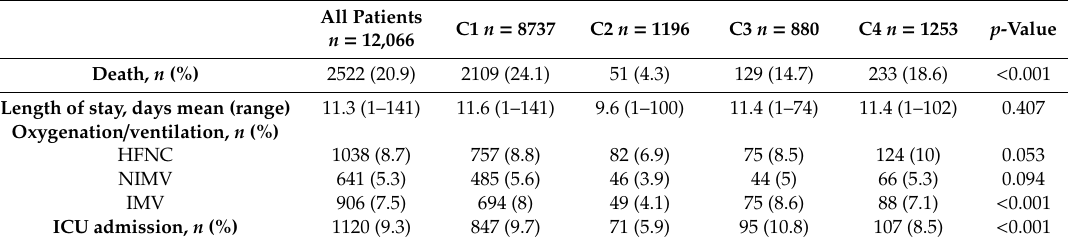
Table 5. Outcomes between clusters.